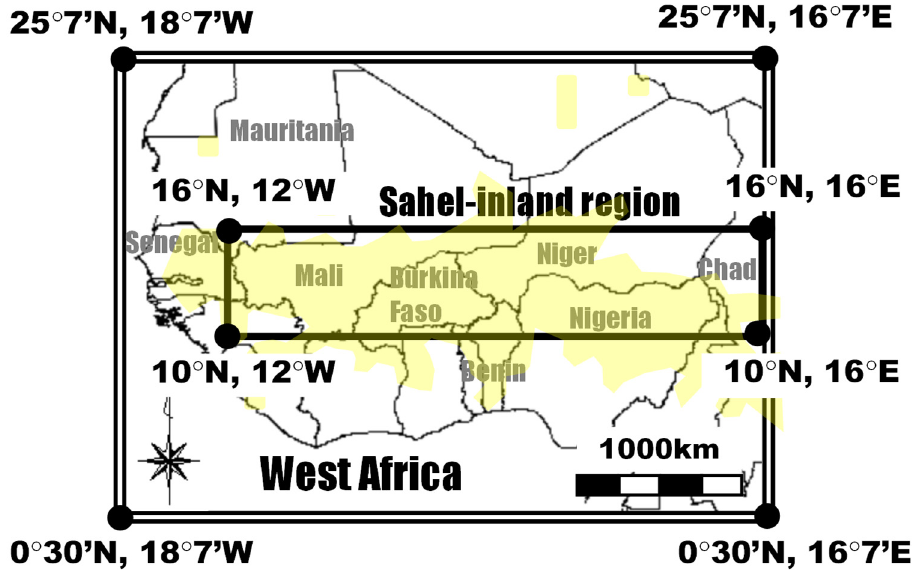
Figure 1. Simulation domain (0°30 ′ –25°7 ′ N, 18°7 ′ W–16°7 ′ E) and study area (10°–16° N, 12° W–16° E) in West Africa. Agricultural drought assessment was conducted for the Sahel-inland region; yellow shading indicates the general area of pearl millet cropland [15].